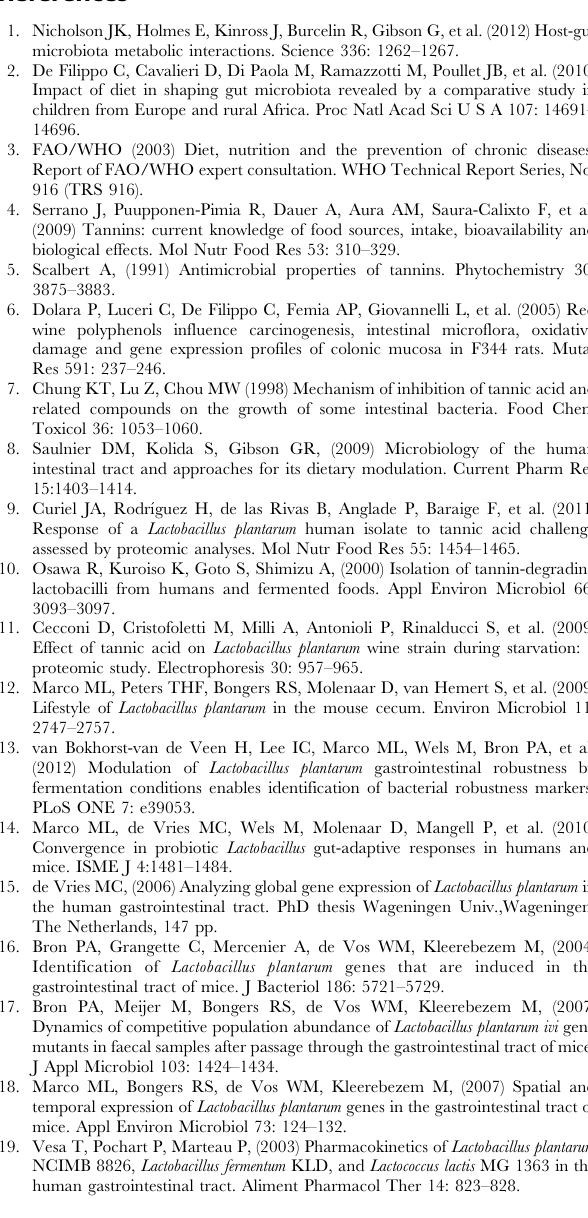
Table S1 Oligonucleotides used for RT-qPCR in this study designed with the Primer Express 3.0 software. a Designated gene number for the annotated L. plantarum